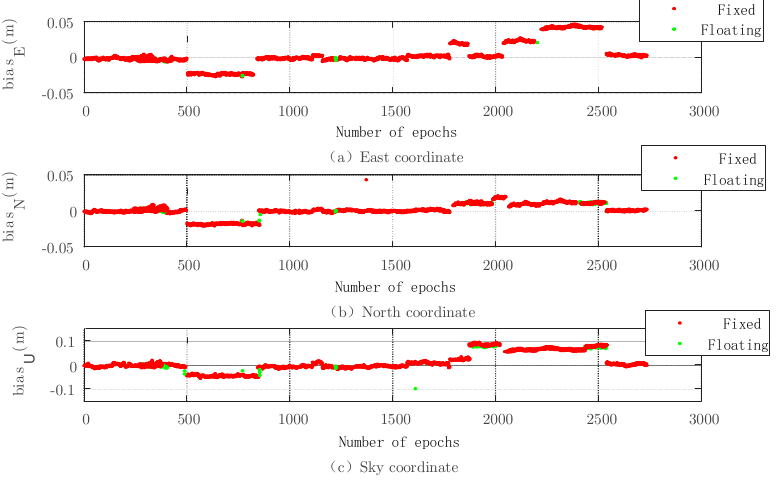
Figure 8. Three − dimensional baseline solution results based on the New-Breadth-First search